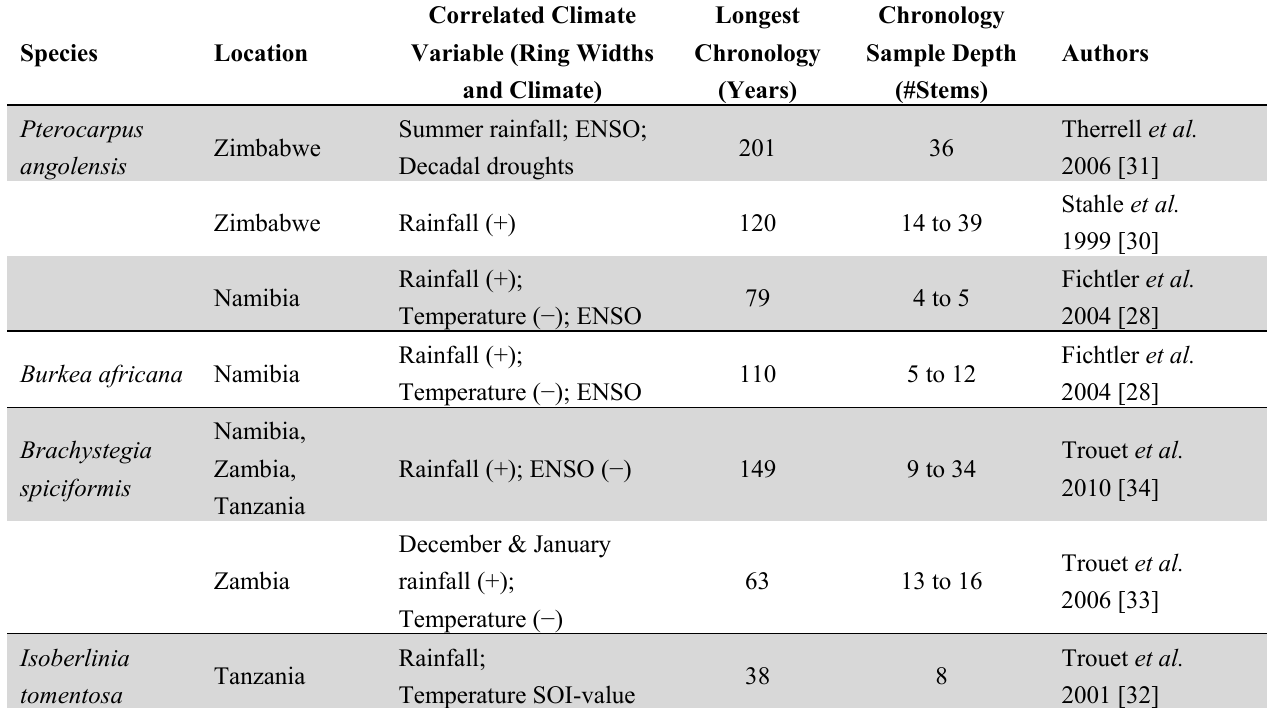
Table 2. Dendroclimatological potential for several locally common species in southern